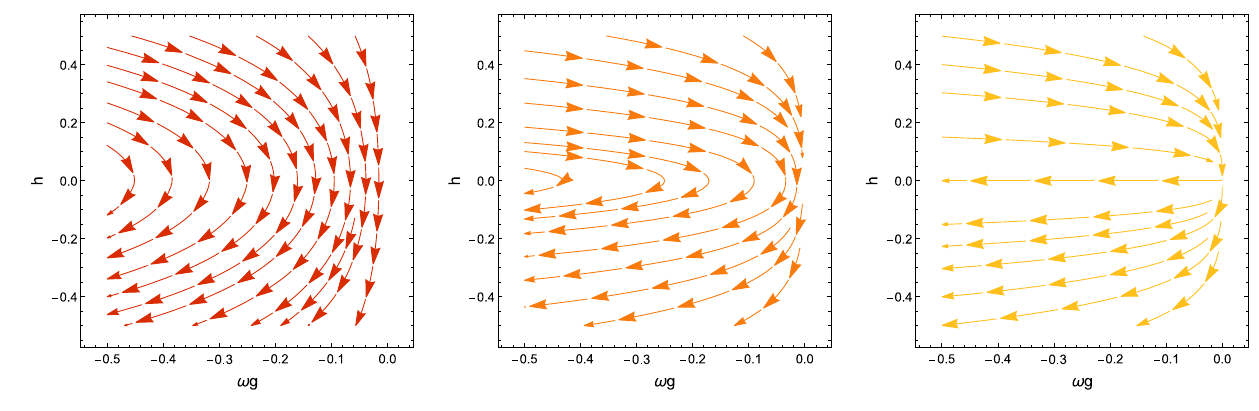
Fig. 6 Phase-space diagram for the dynamical system (31)–(35) in the ω g − h surface for γ = 4